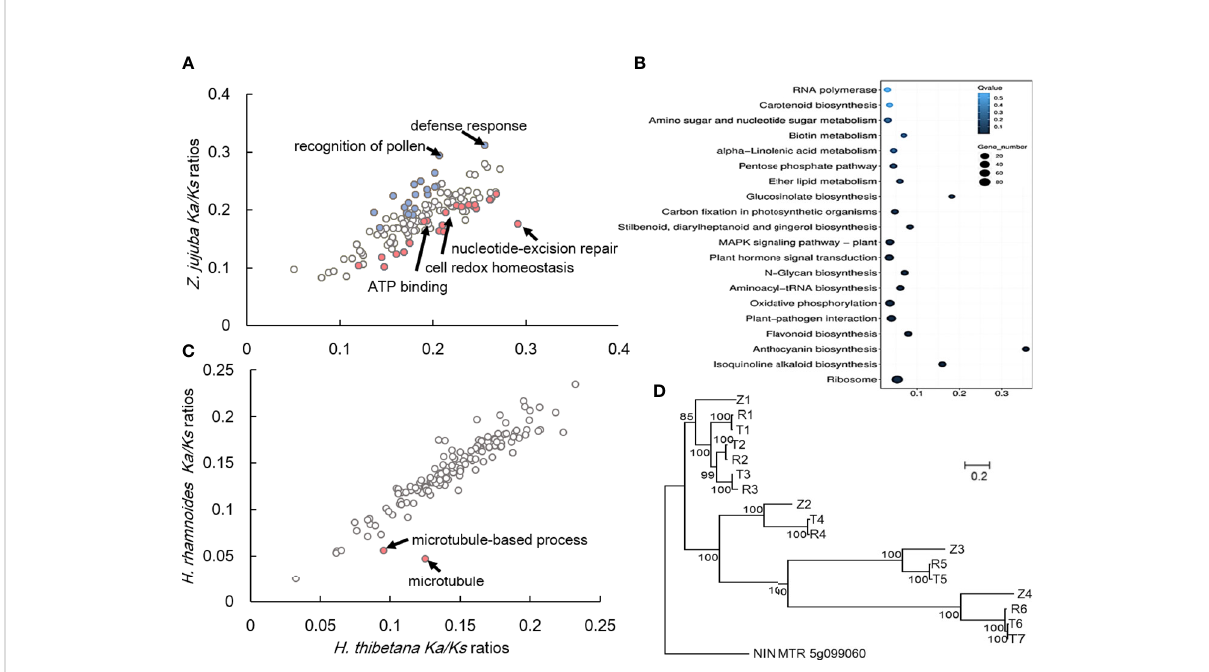
FIGURE 3 Rapid evolution gene and speci fi c gene sets (expansion-related genes and genes under positive selection) in ” H. tibetana. (A) GO categories with putatively accelerated ( ” P < 0.05, binomial test) nonsynonymous divergence in ” H. thibetana (red) or Z. jujuba (blue) are highlighted. (B) Functional enrichment of the expansion genes, the gene number and the signi fi cation of each GO term was indicated by size and color of dot; (C) GO categories with putatively accelerated ( P < 0.05, binomial test) nonsynonymous divergence in ” H. thibetana (red) or H. rhamnoides are highlighted; (D) Maximum-likelihood phylogenetic tree of NODULE INCEPTION in Z. jujuba, ” H. rhamnoides and ” H. tibetana . The scale bar shows the expected number of amino acid substitutions per